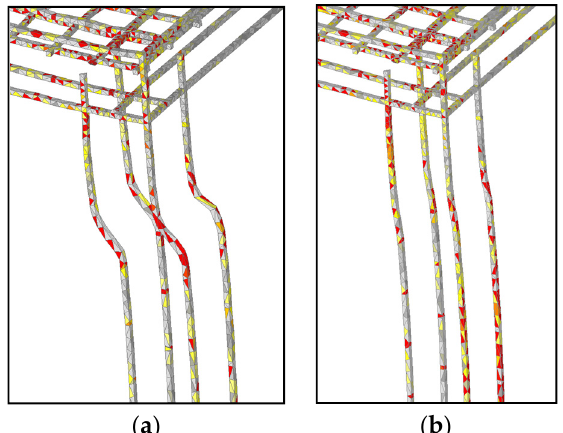
Figure 16. Stresses and deformations in column reinforcement after 60 min of fire exposure at peak reaction: ( a ) hot state and ( b ) cold state; red corresponds to the maximum principal stress of approximately 300 MPa.